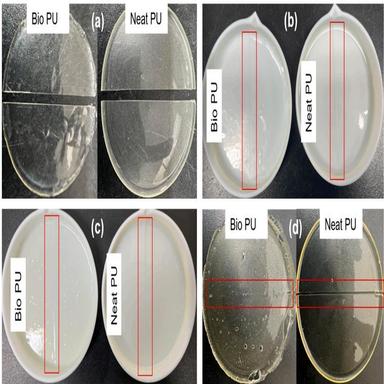
Self-healing test of bio PU and neat PU films: PU films were cut into two separate specimens (a), two specimens were put into PTFE molds for drying (b), PU films after drying at 60 ◦C overnight (c), and completely self-healed bio PU and non-healed neat PU films (d).